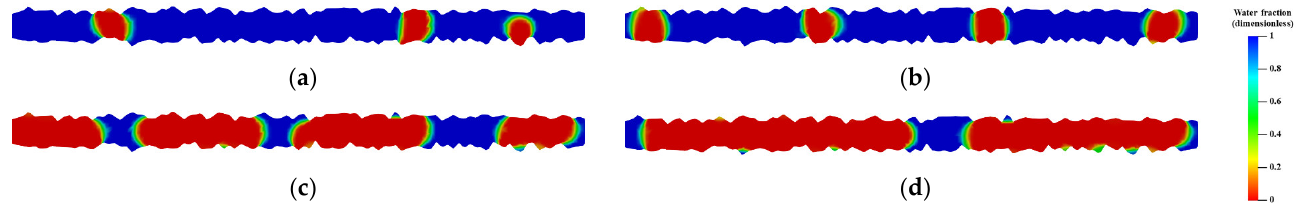
Figure 12. Snapshots of the gas and water distribution in single-fracture models with gas/water ratios of ( a ) 1:9; ( b ) 1:4; ( c ) 4:1; and ( d ) 9:1. Refer to Figure 4 for the color bar.